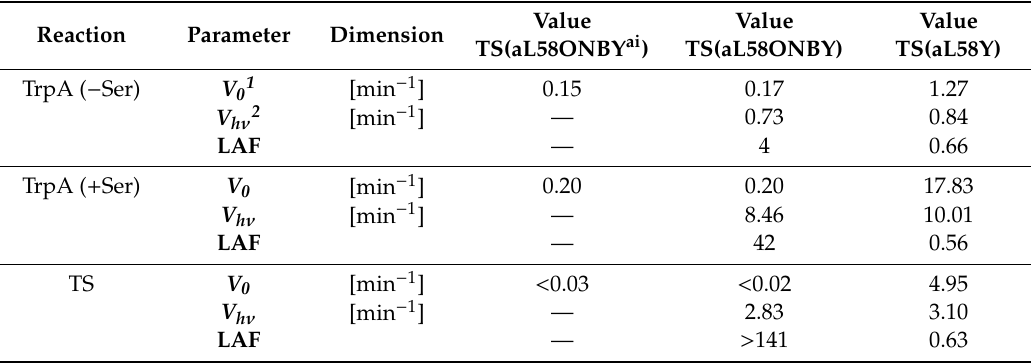
Table 4. Activity parameters of the direct photo-control of TS(aL58ONBY) compared to TS(aL58ONBY ai ) and TS(aL58Y). Experimental data are shown in Figure 8. Value Reaction Parameter Dimension